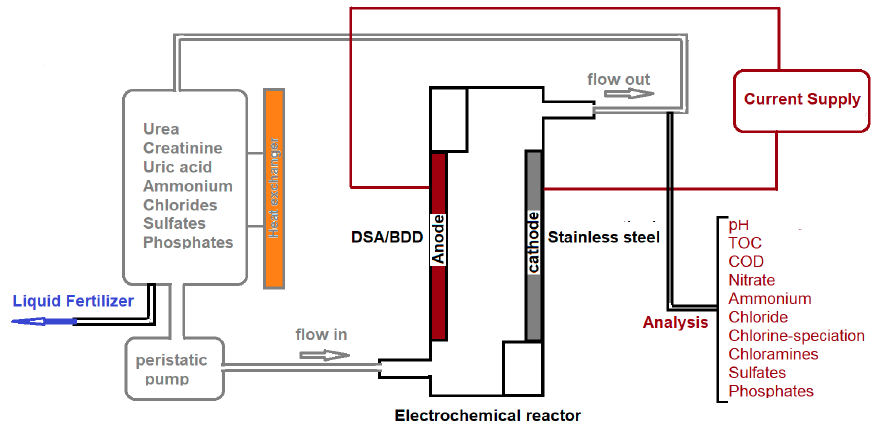
Figure 1. Experimental setup and procedures used during electrolytic treatment.